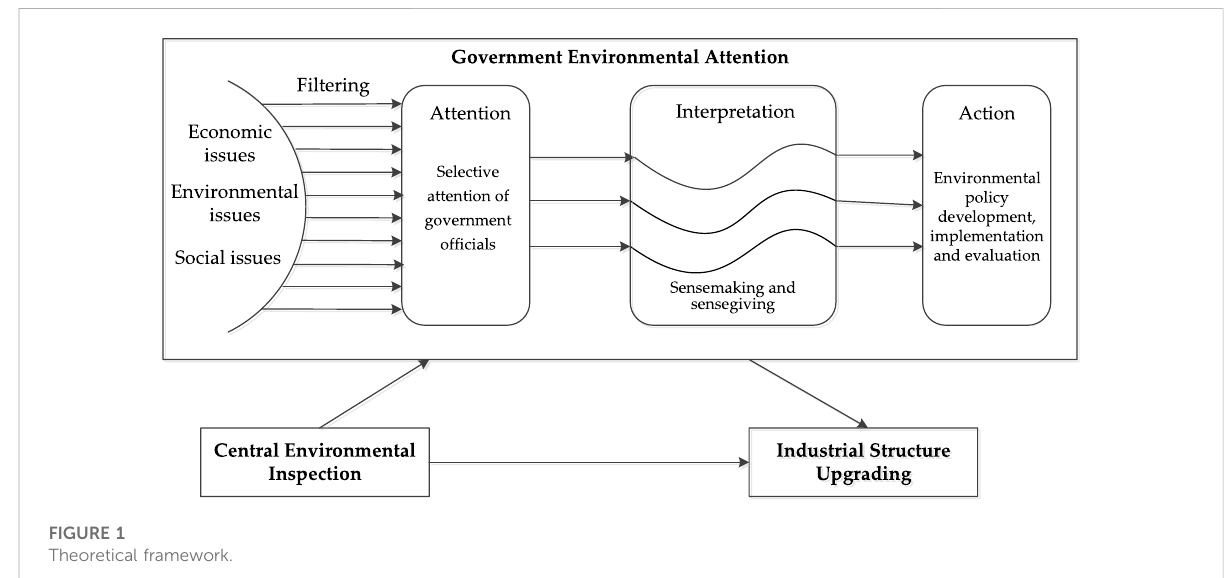
FIGURE 1 Theoretical